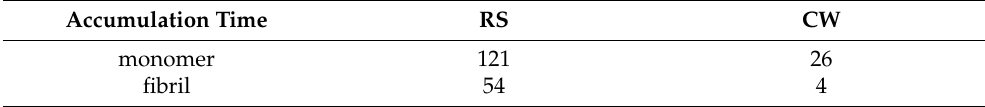
Table 1. Comparison of the signal-to-noise ratios of RS and CW EPR experiments with spectra acquired for 1 min. The SNR of the RS EPR spectra were determined prior to pseudo-modulation. Accumulation Time RS CW monomer 121 26 fibril 54